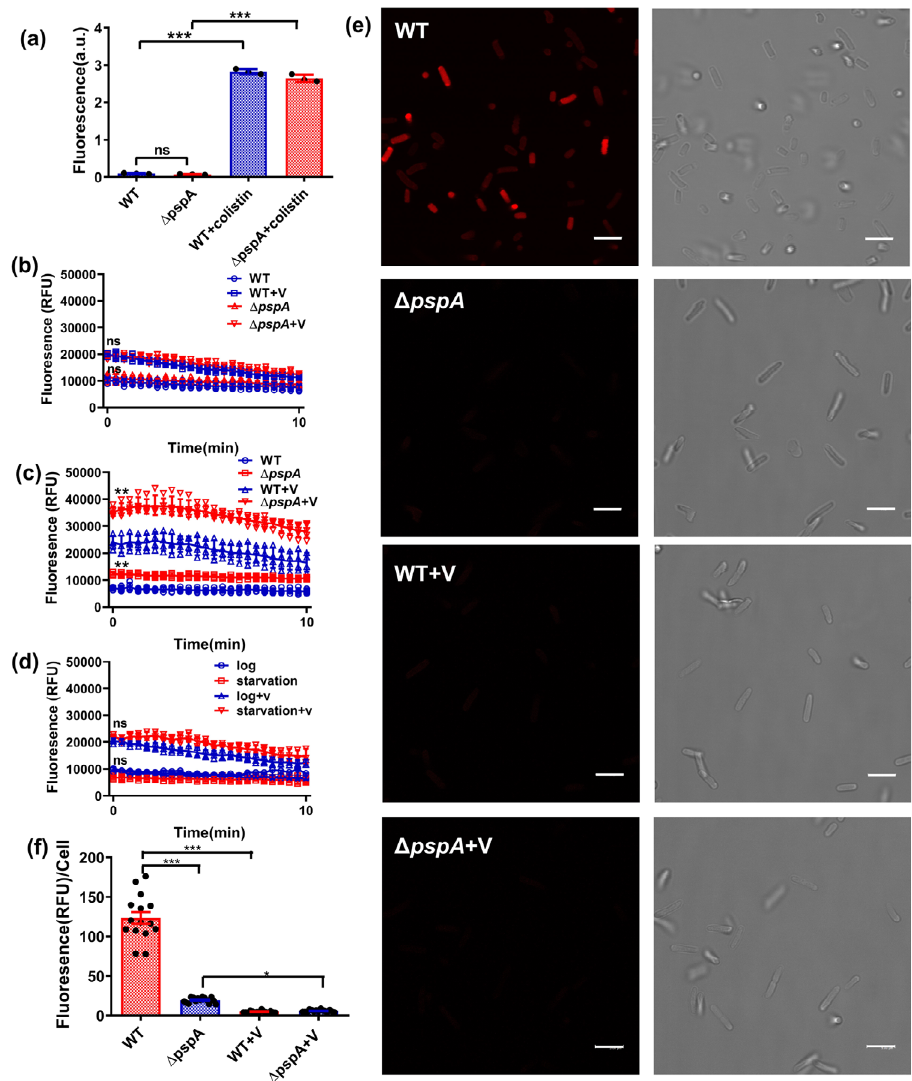
Fig. 2 Psp response helps maintain PMF during starvation in E. coli without altering membrane permeability. a Fluorescence intensity of SYTOX Green, which was used to detect membrane permeability of the wild type and Δ pspA strains, showed that the cell membrane in the Δ pspA strain remained intact; strains treated with colistin were included as a positive control. b Comparison between the fl uorescence intensity of DiSC 3 (5)-stained cells in the exponential growth phase of both wild type and Δ pspA strains reveals the same initial intensity and a similar degree of changes in membrane potential upon addition of valinomycin (labeled as V). P values were calculated between group (WT and Δ pspA ; WT + V and Δ pspA + V) at the beginning time point. c Comparison between the fl uorescence intensity of DiSC 3 (5)-strained wild type and the Δ pspA strain, which had been subjected to starvation for 24 h depicts a much higher fl uorescence intensity and hence a much lower PMF in the Δ pspA mutant. P values were calculated between group (WT and Δ pspA ; WT + V and Δ pspA + V) at the beginning time point. d Comparison between the fl uorescence intensity of DiSC 3 (5)-stained exponentially growing wild type population and those, which had been subjected to 24 h starvation reveals a similar initial fl uorescence intensity and also a similar degree of changes in fl uorescence intensity, and hence membrane potential, upon addition of valinomycin. n > 3 biologically independent experiments. Error bar represents standard deviation. P values were calculated between group (WT and Δ pspA ; WT + V and Δ pspA + V) at the beginning time point. e Confocal microscopy images of DiSC 3 (5)-stained cells, which have been subjected to 24 h starvation in the absence and presence of valinomycin. The left and right panels are the fl uorescence and bright- fi eld images, respectively, (scale bar: 5 μ m). f The mean DiSC 3 (5) fl uorescence intensity of the confocal microscopy image, which was calculated by the LAS X software. Data are the average of three observation fi eld images. ns indicate no signi fi cance, * indicate a P value of <0.05, **indicate a P value of <0.01, ***indicate a P value of <0.001 by two-tailed Student ’ s test. Error bar represents standard